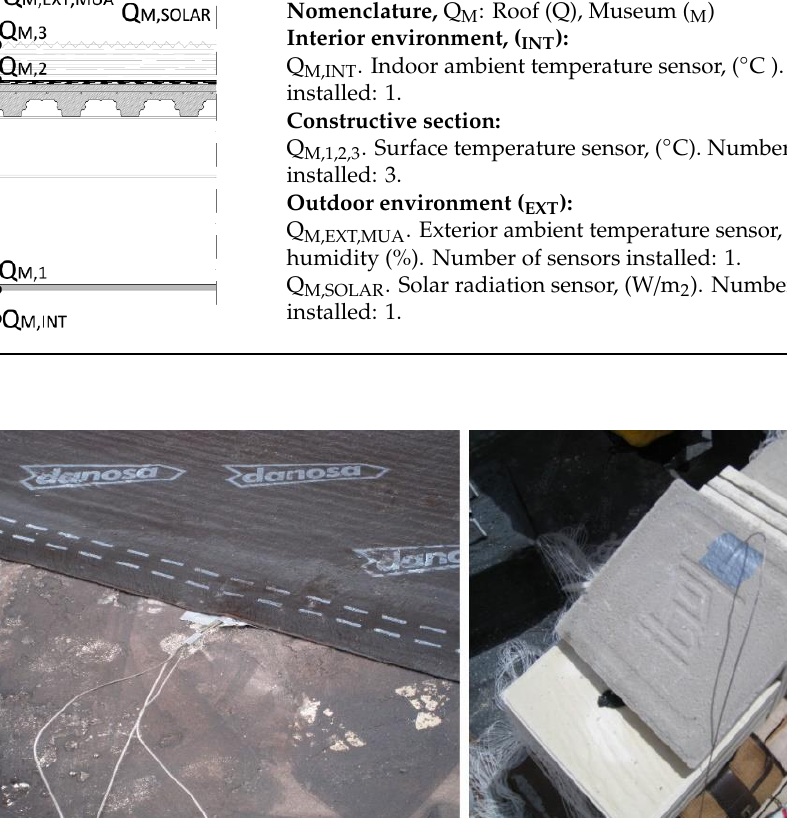
Figure 5. Installation of surface Type K thermocouple sensors on the apartment’s inverted flat roof.